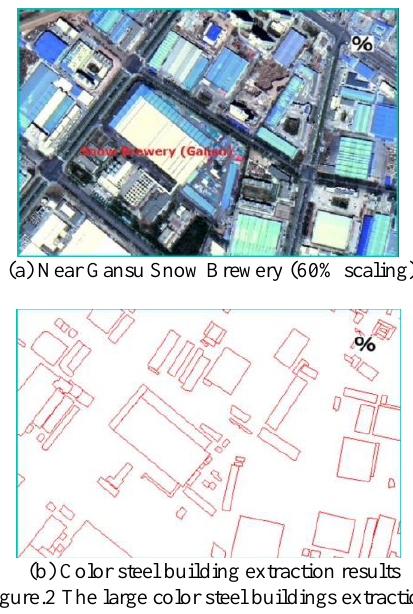
Figure.2 The large color steel buildings extraction based on the GF-2